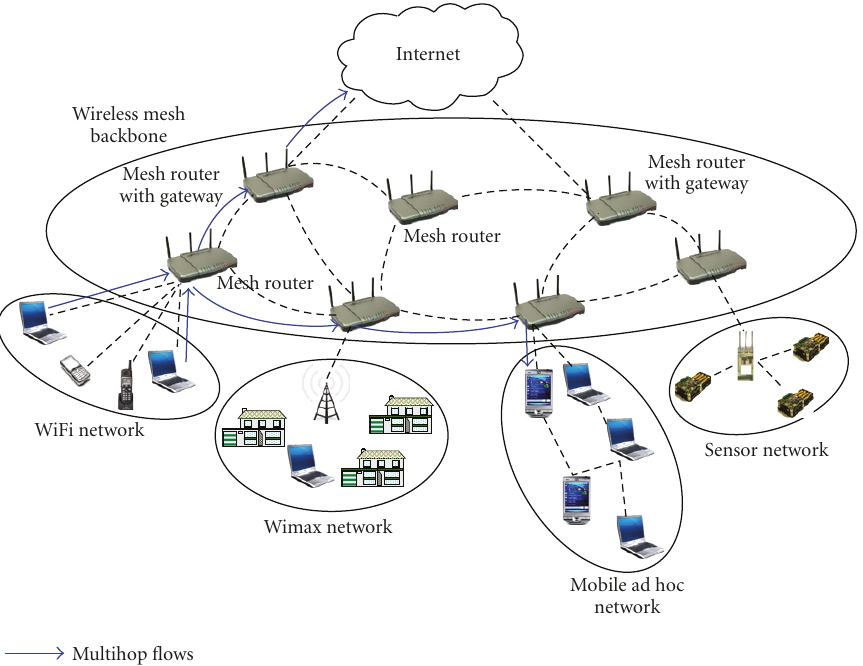
Figure 1: A wireless mesh